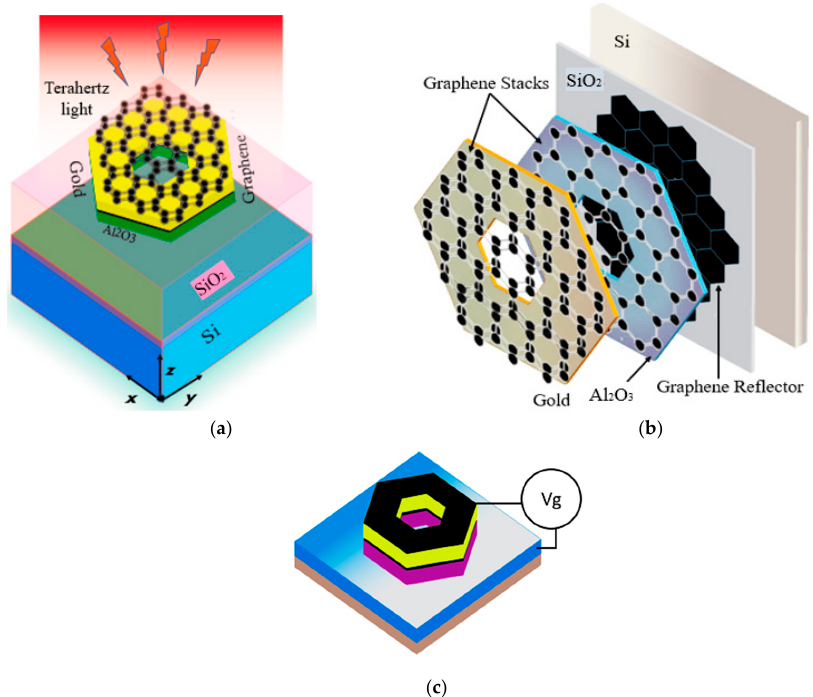
Figure 2. Proposed geometry of graphene-metal hybrid nanoantenna. ( a ) Top view of the graphene stack antenna, as the antenna is illuminated by THz light in the frequency range of 30–34 THz and is incident on the surface of antenna parallel to the z-axis, ( b ) layered view of the antenna structure, as the antenna structure is composed of eight-layers, i.e., three-layers of substrates, two graphene stacks, a gold layer, and graphene reflector, and ( c ) gating of the proposed antenna by applying a voltage across graphene sheets for the tuning of Fermi energy in the range of 0.1 eV–0.3 eV.